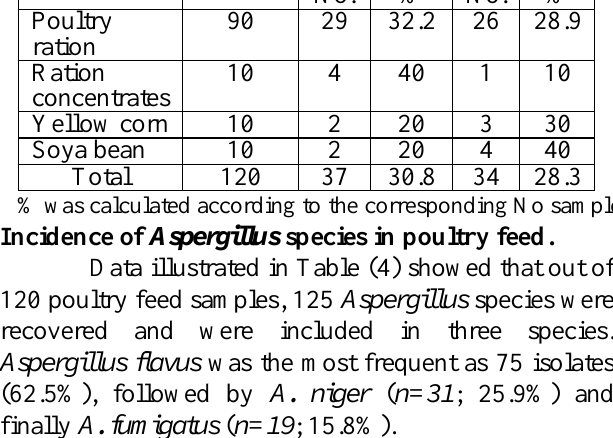
Table 4: Incidence of Aspergillus species in the